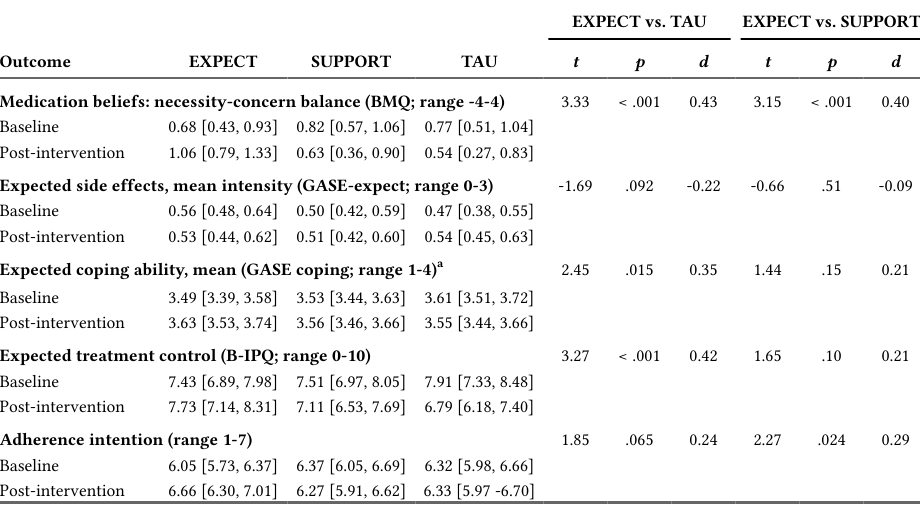
Outcome Measures at Baseline and Post-Intervention Outcome EXPECT SUPPORT TAU